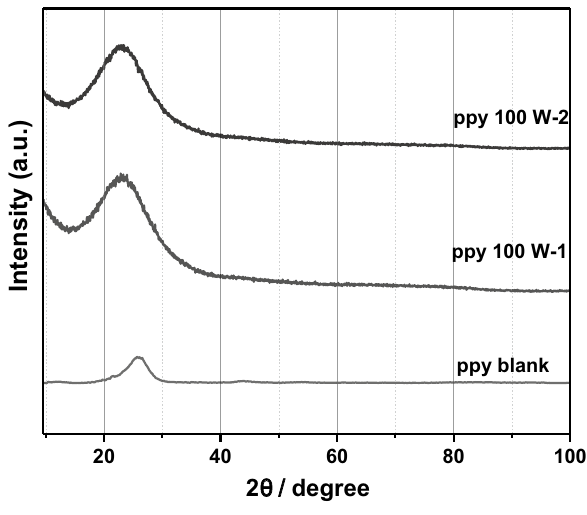
Fig. 1 Diffractogram of ppy blank, ppy 100W-1 and ppy 100W-2